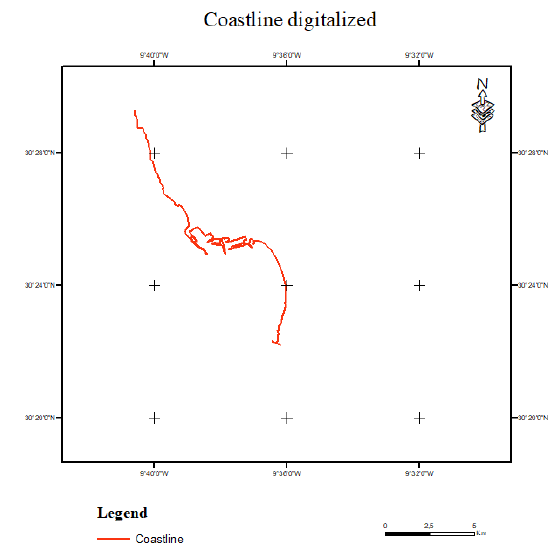
Figure5 . Isohypse "0", Coastline.